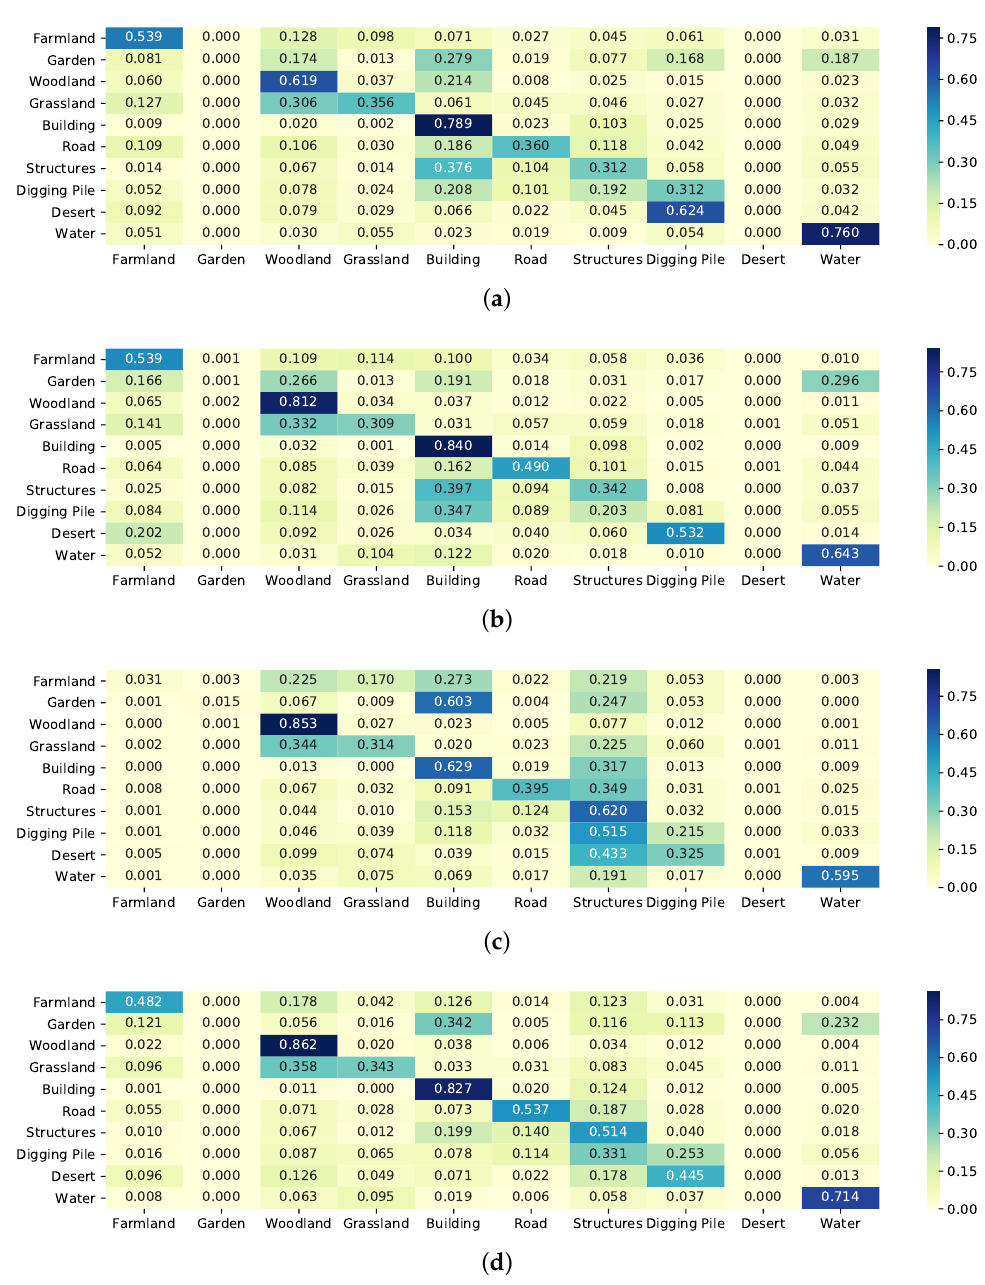
Figure 14. Confusion matrices on the Evlab dataset. ( a ) PSPNet; ( b ) DeepLab V3+; ( c ) SDFCN V1; ( d )